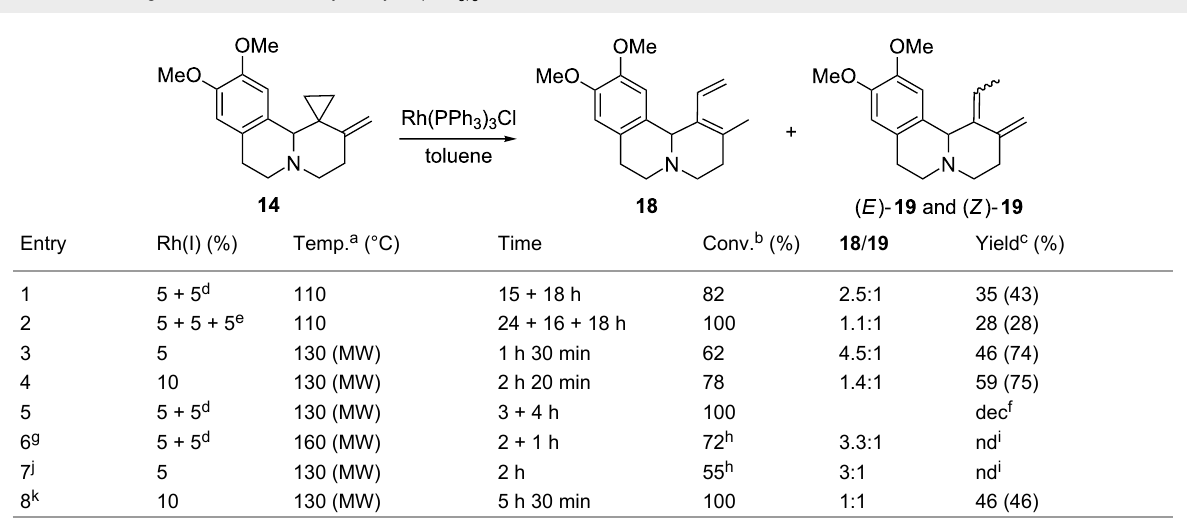
Table 1: Rearrangement of VCP 14 catalyzed by Rh(PPh 3 ) 3